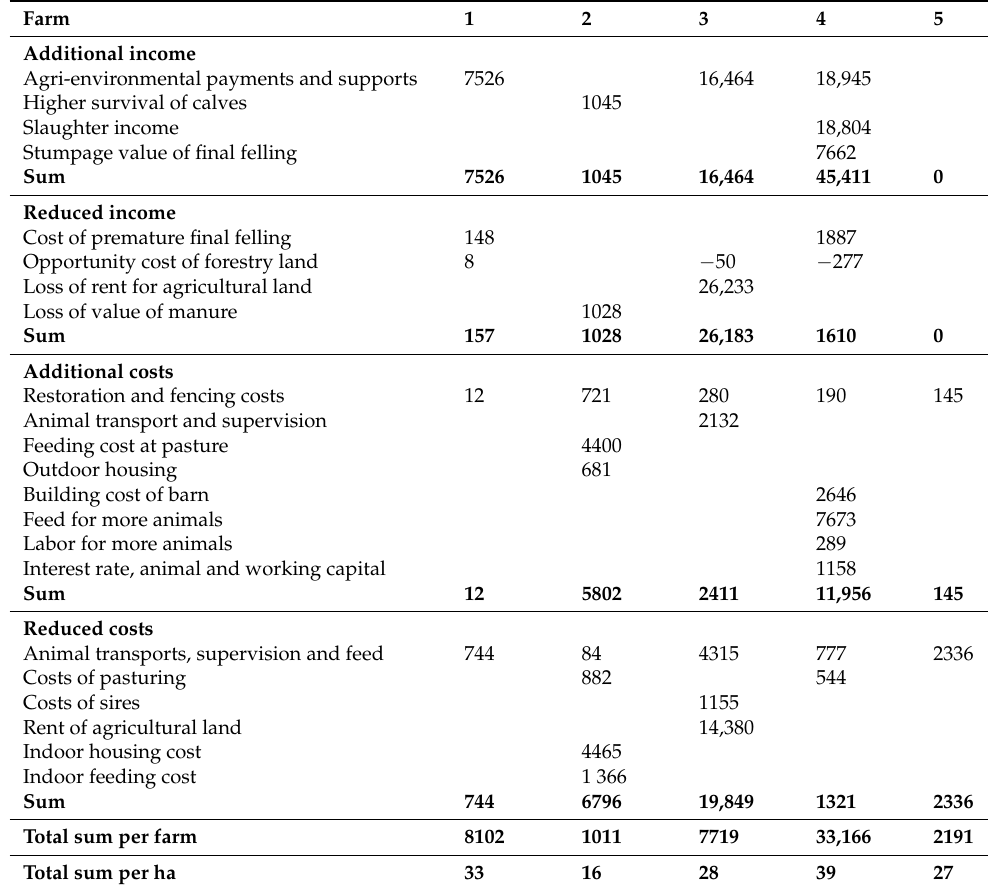
Table 3. Change in profitability, Euro ( € ) per farm and year, according to the partial budgeting model, summing up additional income, reduced income, additional costs and reduced costs, attributable to the creation of larger coherent pasturelands from small scattered pastures in five Swedish cow-calf enterprises